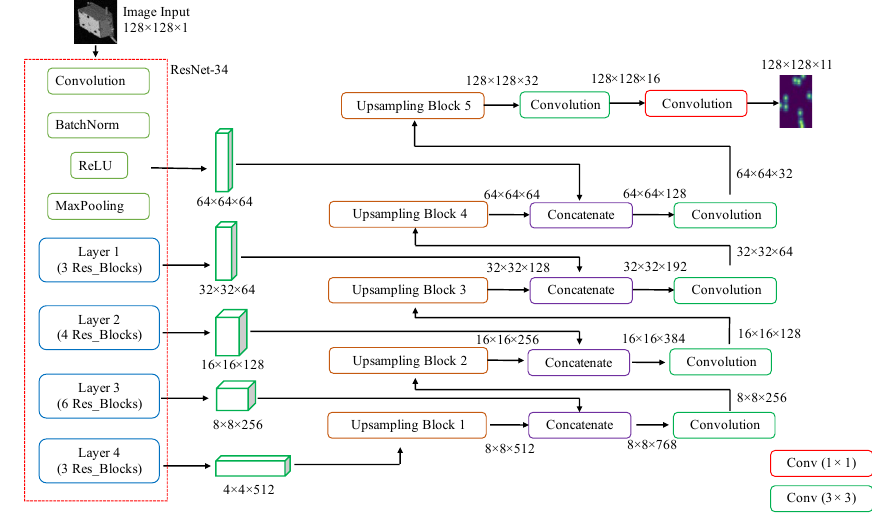
Figure 11. ResNet34-U-Net